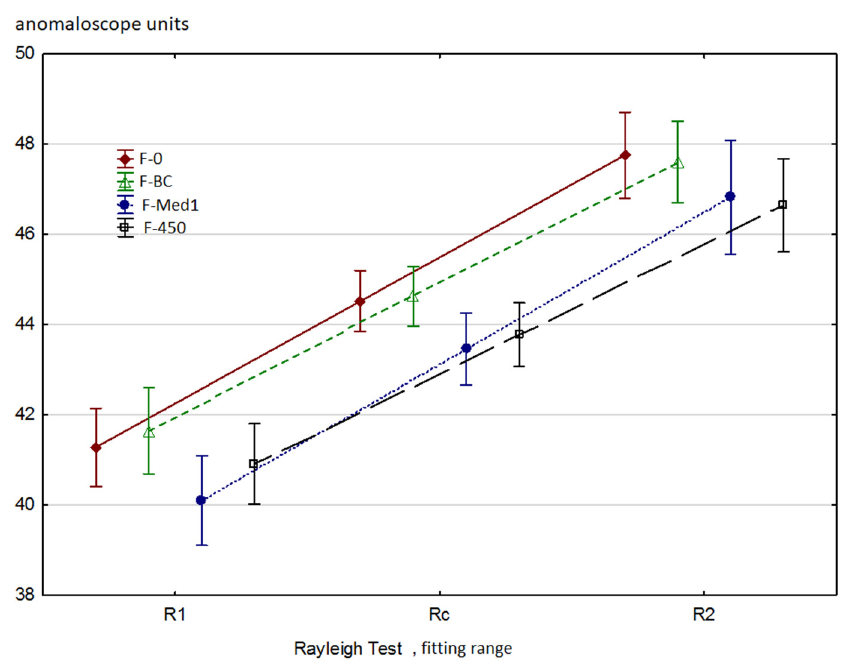
Figure 4. The impact of filters on the Rayleigh test results. The anomaloscope units refer to the red-green diode proportion in the test field: 0 au: 100% red and 0% green; 73 au: 100% red and 0% green. A certain reduction in R 1 and R 2 values is noticeable following the application of the F-Med1 and the F-450 filters. Statistical significance of the differences observed in the Wilcoxon test is presented in Table 4. Table 4. Statistical significance of the differences in the Wilcoxon test for R 1 and R 2 , as per filter types (see Table 2 and Figure 4). R 1 results are presented top-right while R 2 results are to be found bottom-left. The effect of filtering on both parameters is noticeable, while there is no impact on R W (i.e., the ability to perceive color tones between lemon and orange). R 1